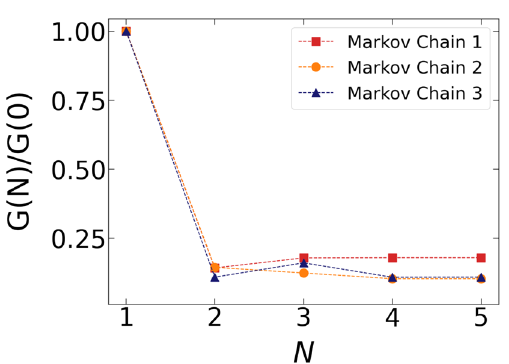
Figure 5. The ratio of auto-correlation function G ( N )/ G (0) (see Eq. (S29) in SI) plotted as a function of Monte Carlo steps N for three independent Markov